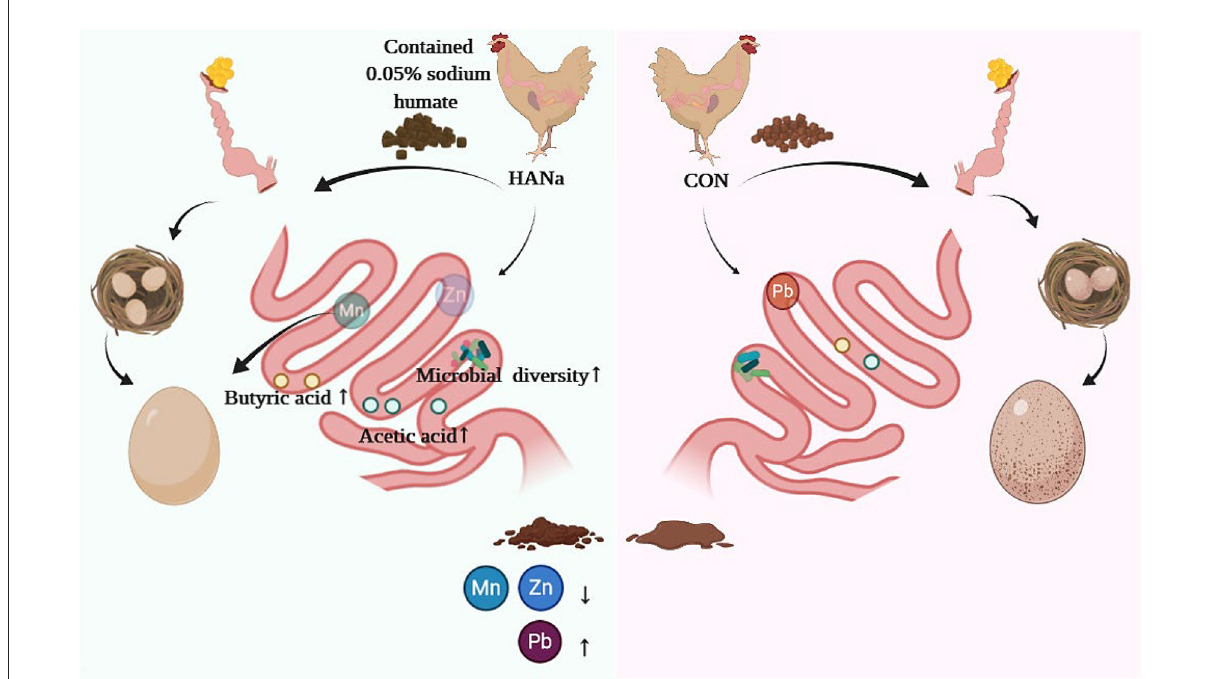
FIGURE4 Schematic diagram showing how sodium humate alters the intestinal microbiome of old hens to improve the formation of short-chain fatty acids and the utilization of trace